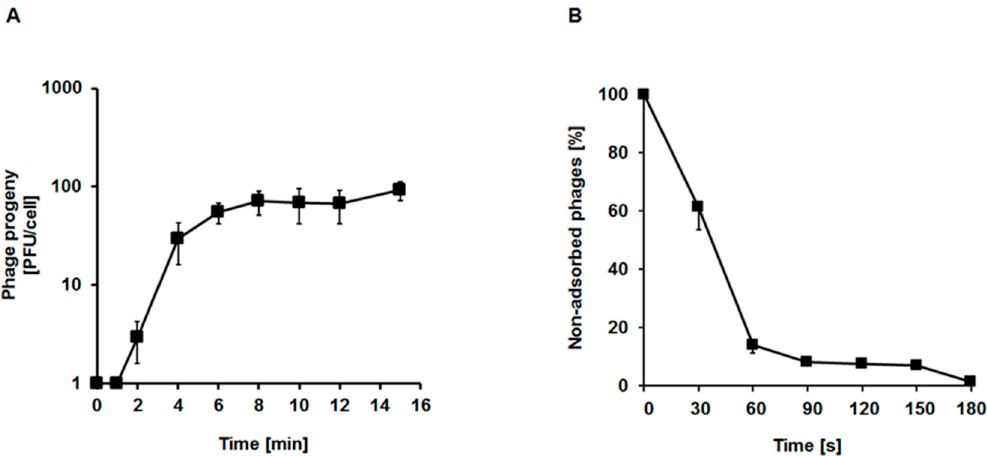
Figure 6. Kinetics of phage progeny production during one-step growth experiment ( A ) and the adsorption rate ( B ) of phage vB_EfaS-271 on the E. faecalis strain 271 measured at M.O.I. of 0.01 and 0.05, respectively. The results are shown as mean values ± SD from three biological experiments. Note that in some cases, the error bars are smaller than the sizes of the symbols.